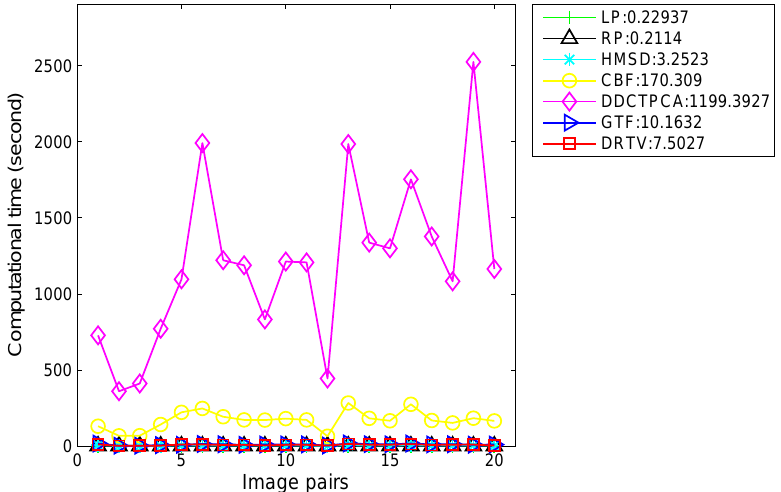
Figure 7. Runtime comparison of different methods on the whole test